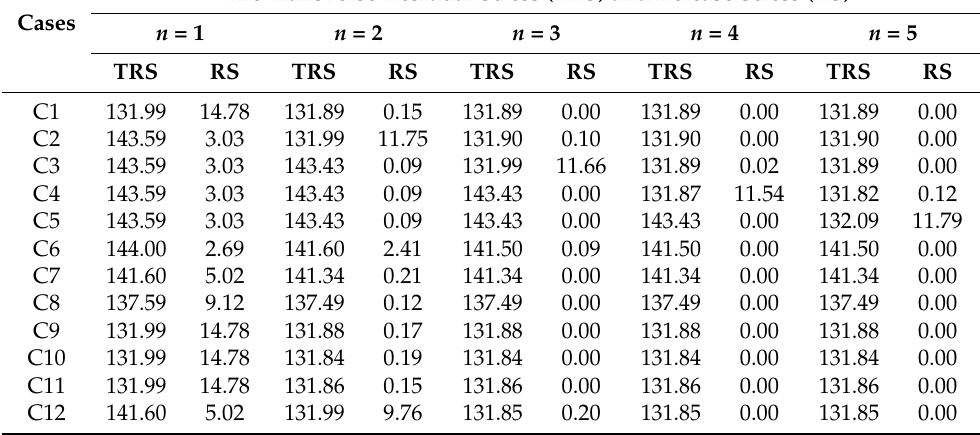
Figure 21. The transverse welding residual stress of C1‒C12: ( a ) C1 ‒ C5; ( b ) C6 ‒ C9; ( c ) C9 ‒ C12. Table 4 shows the transverse residual stress and release stress under variable-amplitude loading cycles from 0 to 5. For variable amplitude loading cases, if ( σ app ) ≥ ( σ ) ≥ ( σ ) , the residual stress is released only during the first stress cycle. Therefore, app app 4 5 the residual stress release behavior is controlled by the maximum amplitude stress. Once the residual stress is released, the stress will not continue to be released if the DRWDs have the same or smaller amplitude loading. Table 4. The transverse residual stress and release stress under variable-amplitude cyclic loading cases (unit: